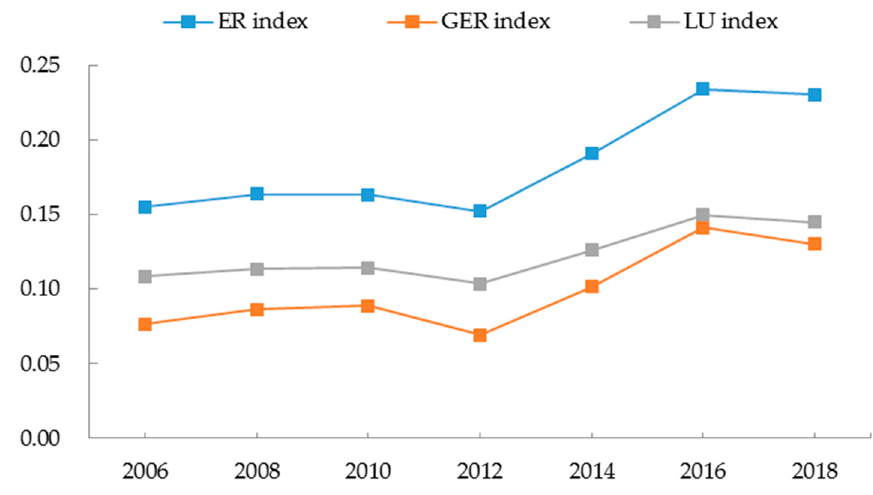
Figure 6. Trends in the evolution of the spatial polarization index of EWP in China.